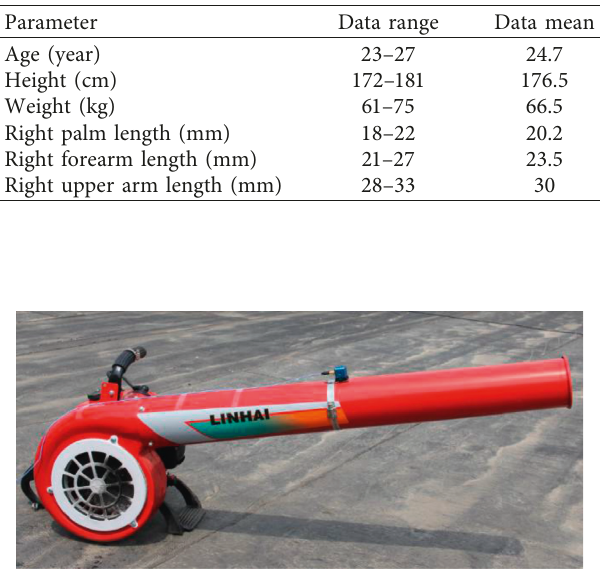
Figure 3: The 6MF-30 portable pneumatic